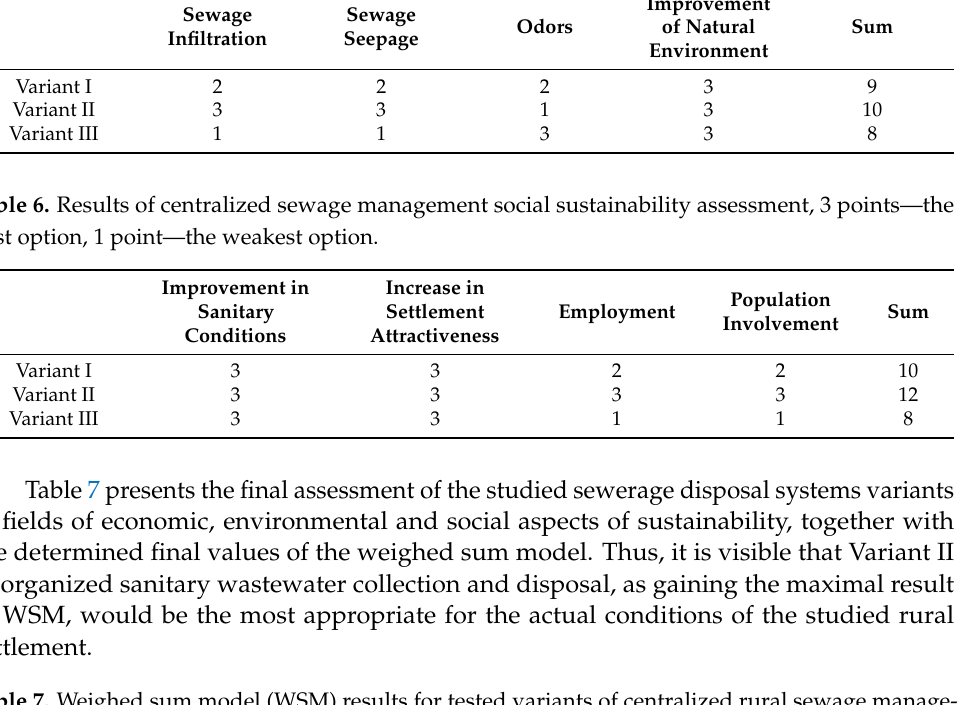
Table 7. Weighed sum model (WSM) results for tested variants of centralized rural sewage manage- ment, underlined for the most optimal